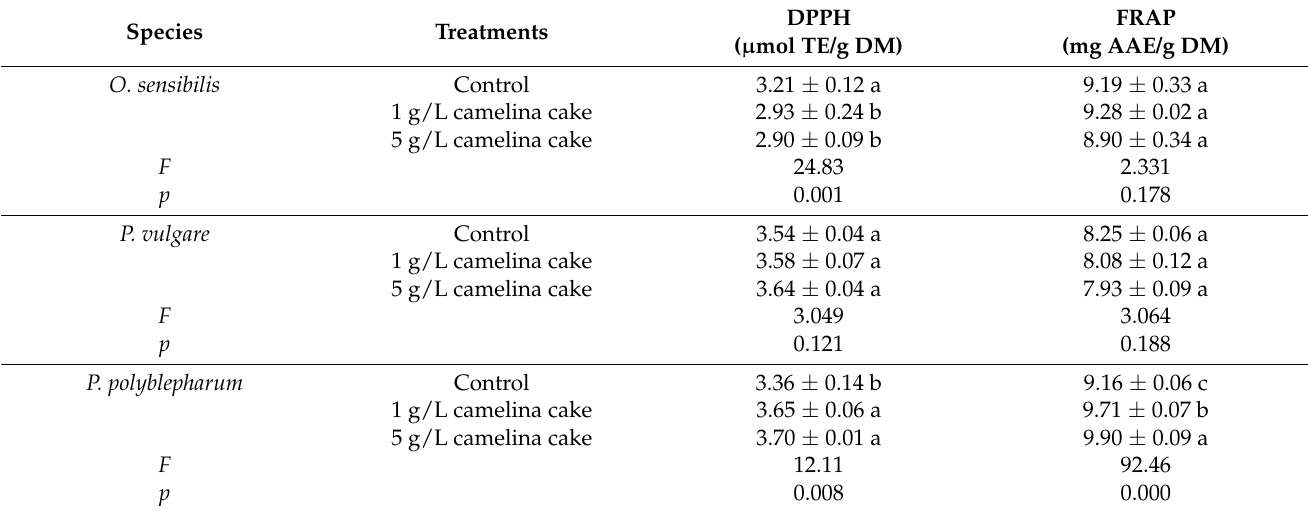
Table 5. The effect of amending peat substrate with camelina cake pellet on antioxidant activity of leaf extracts of hardy